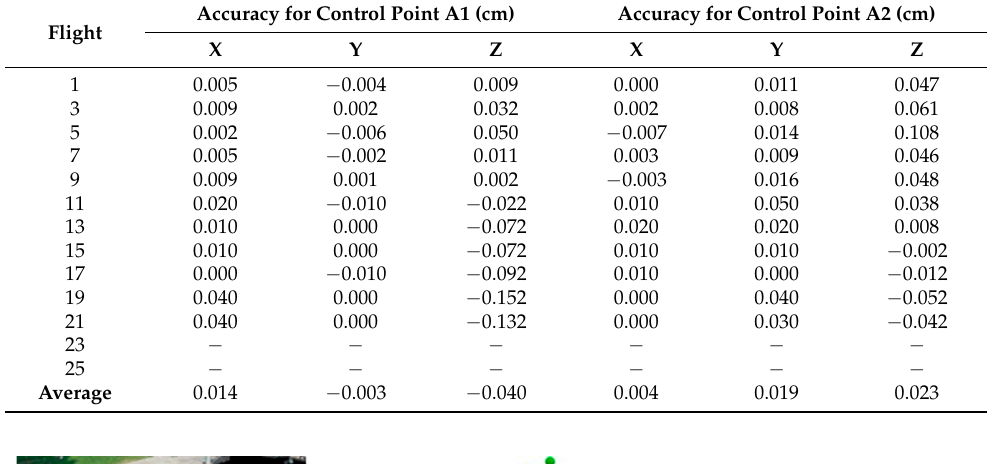
Table 6. Accuracy for control points underwater.